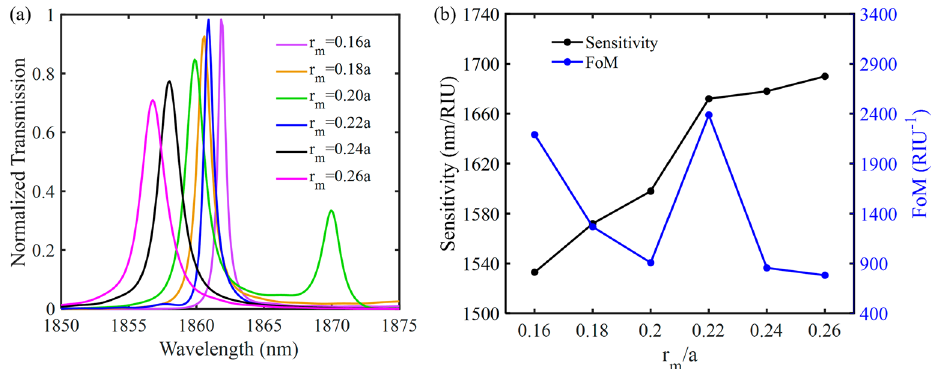
Figure 13. ( a ) The normalized transmission spectrum as a function of the radius of metallic rods ( r m ), ( b ) The effect of the radius of the metallic rods on the sensitivity and FoM.